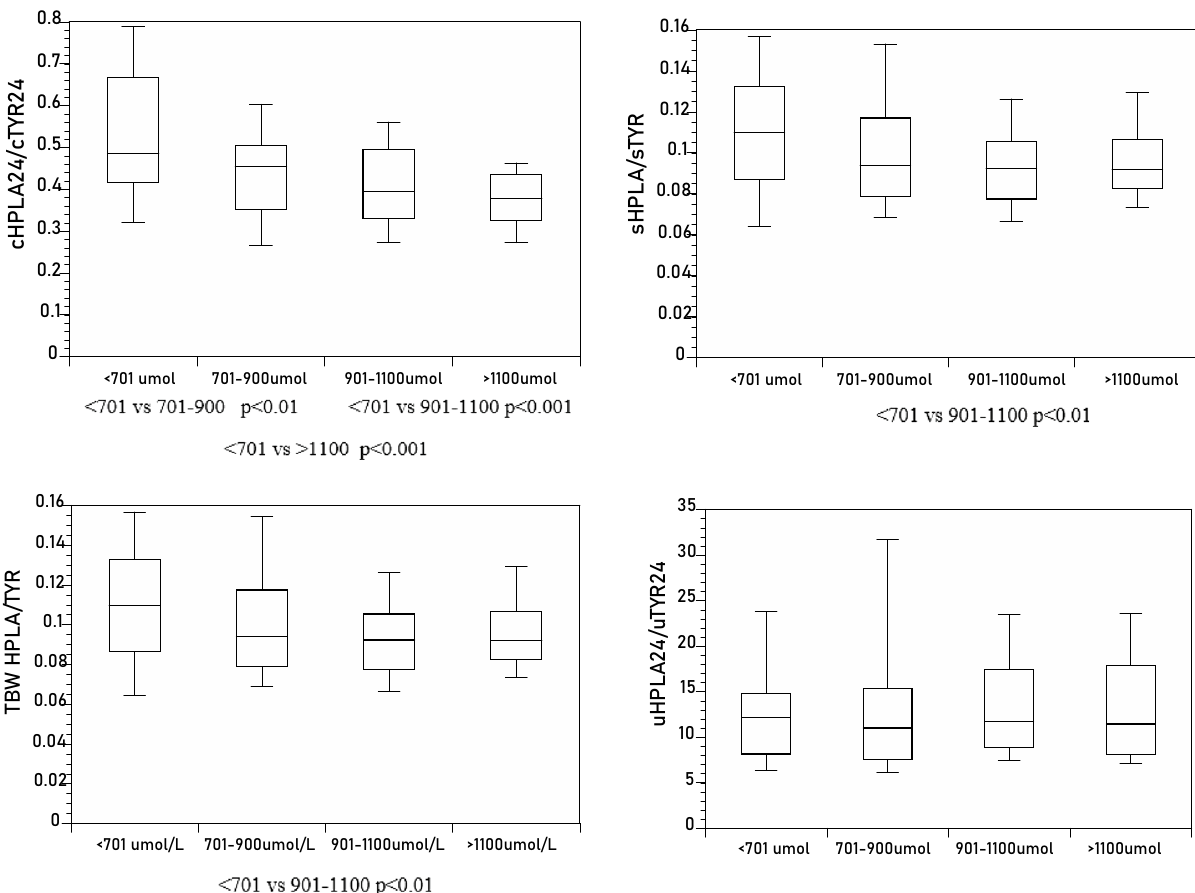
Figure 5. Differences in sHPLA/sTYR, uHPLA 24 /uTYR 24 , tbwHPLA/tbwTYR, and cHPLA 24 /cTYR 24 across the sTYR groups of < 701, 701–900, 901–1100 and > 1100 µmol/L ( p values indicated for within-group comparison where statistical significance was